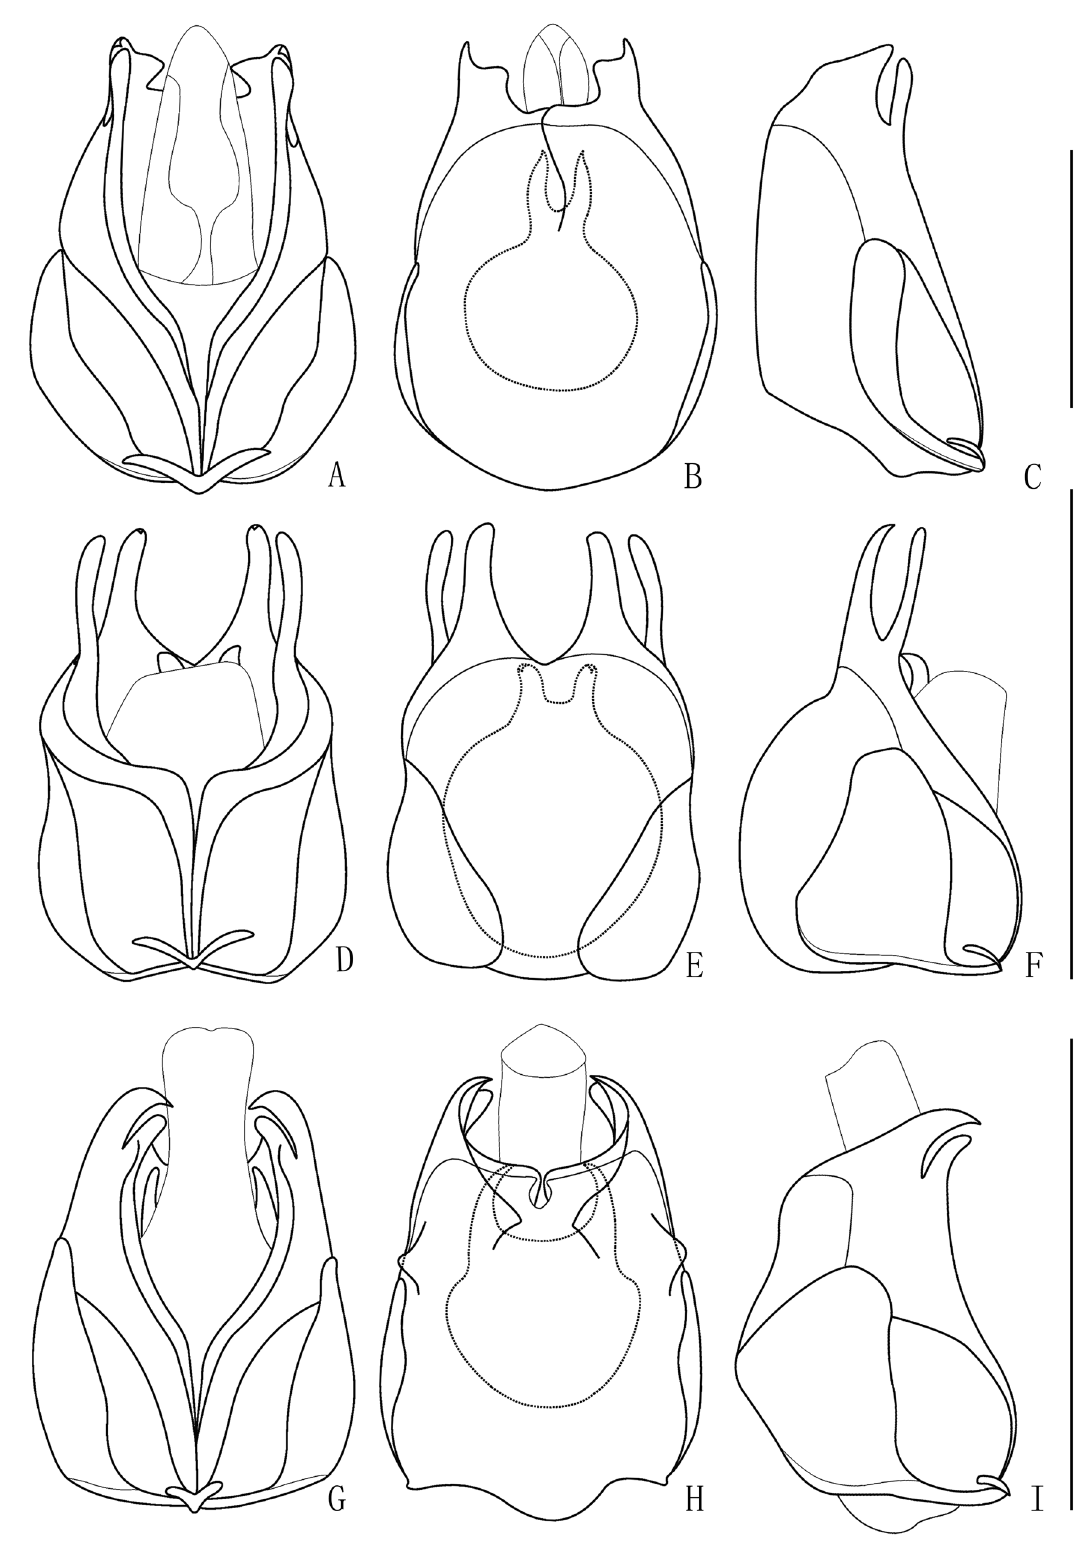
Fig. 3. Aedeagus (A, D, G = ventral view; B, E, H = dorsal view; C, F, I = lateral view). A‒C . Stenothemus biimpressiceps (Pic, 1930) comb. nov. (IZAS). D‒F . S. pallicolor (Wittmer, 1951) comb. nov. (IZAS). G‒I . S. limbatipennis (Pic, 1926) stat. rev. et comb. nov. (MHBU). Scale bars: 1.0